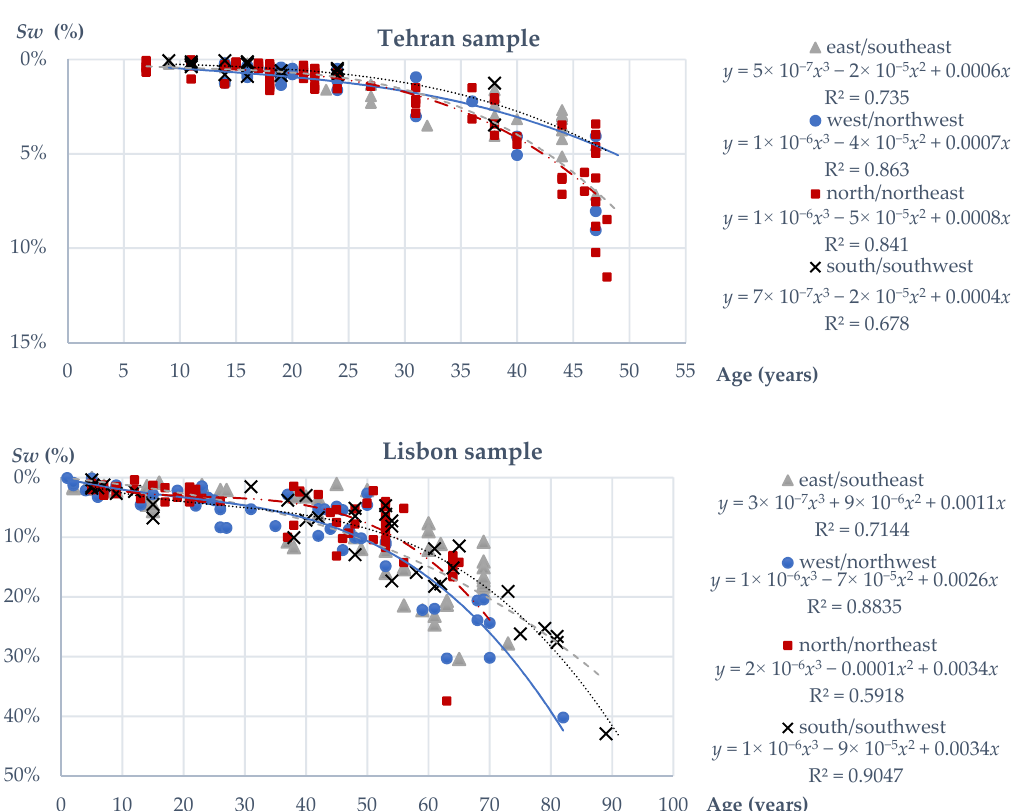
Figure 14. Degradation curves of the Tehran and Lisbon samples, according to the façades’ orientation.